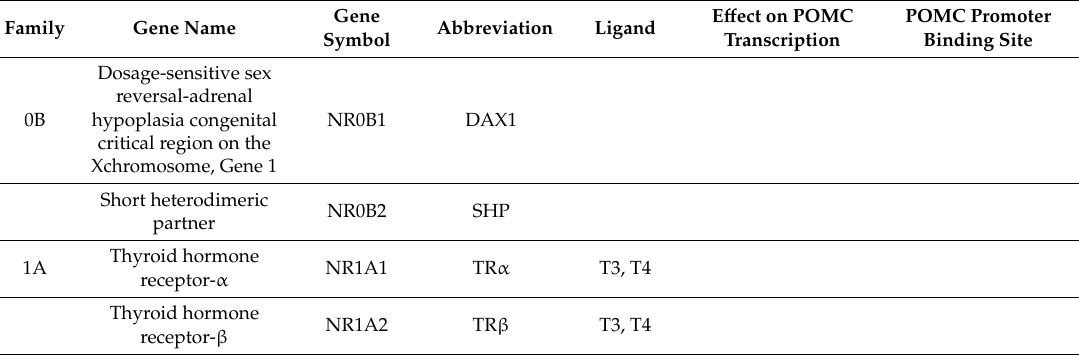
Table 1. Nuclear receptor superfamily proteins and their roles in POMC